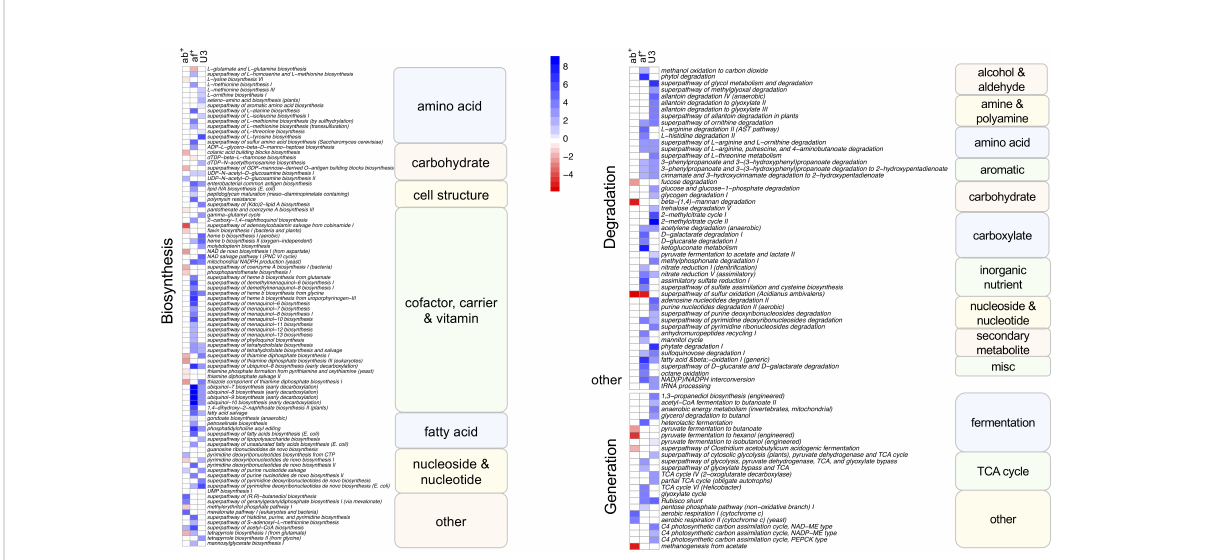
FIGURE 4 Heatmap showing Metacyc pathways signi fi cantly (FDR corrected p<0.05) associated with antibiotic use, antifungal use and age category in a multivariate analysis. Intensity of change is determined as the negative log of the q-value *coef fi cient of change, blue indicates pathways increased with antibiotic use (ab+), antifungal use (af+) or in the under 3 age group (U3) and red are pathways decreased with antibiotic use (ab +), antifungal use (af+) or in the under 3 age group (U3). Pathways are sorted into Metacyc superclasses, and classes. Biosynthesis refers to biosynthesis pathyways; degradation refers to degradation utilization and assimilation pathways, and generation refers to generation of precursor metabolites and energy